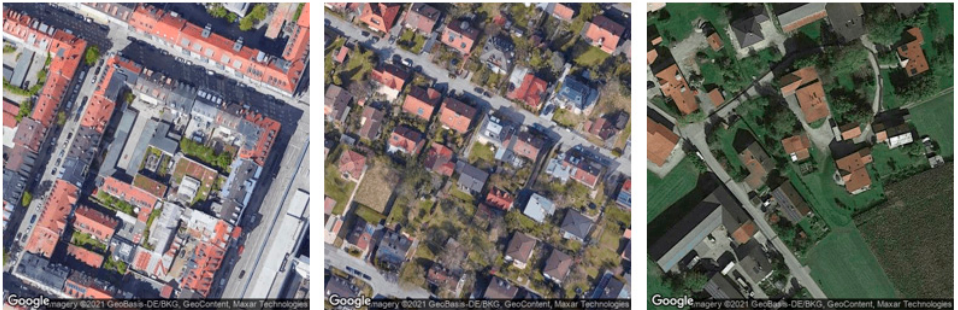
Figure 9. Examples of urban, suburban, and rural aerial images from Google Maps Static API in the greater Munich area.